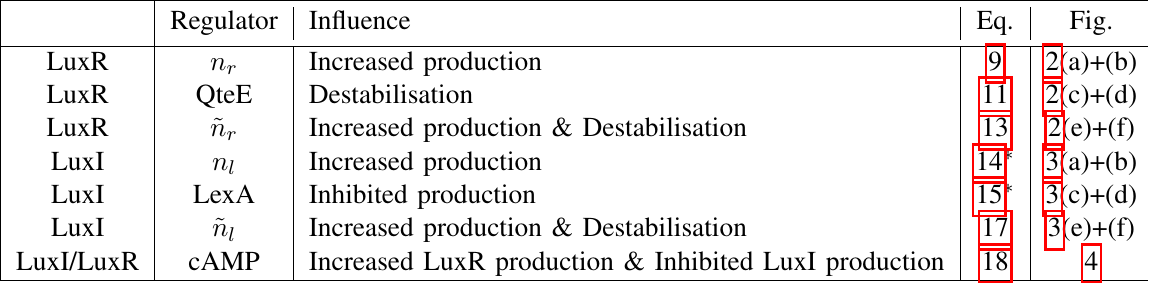
TABLE III: Different scenarios. ∗ Equation referenced has to be inserted into Eq.(2) assuming a quasi- steady state.